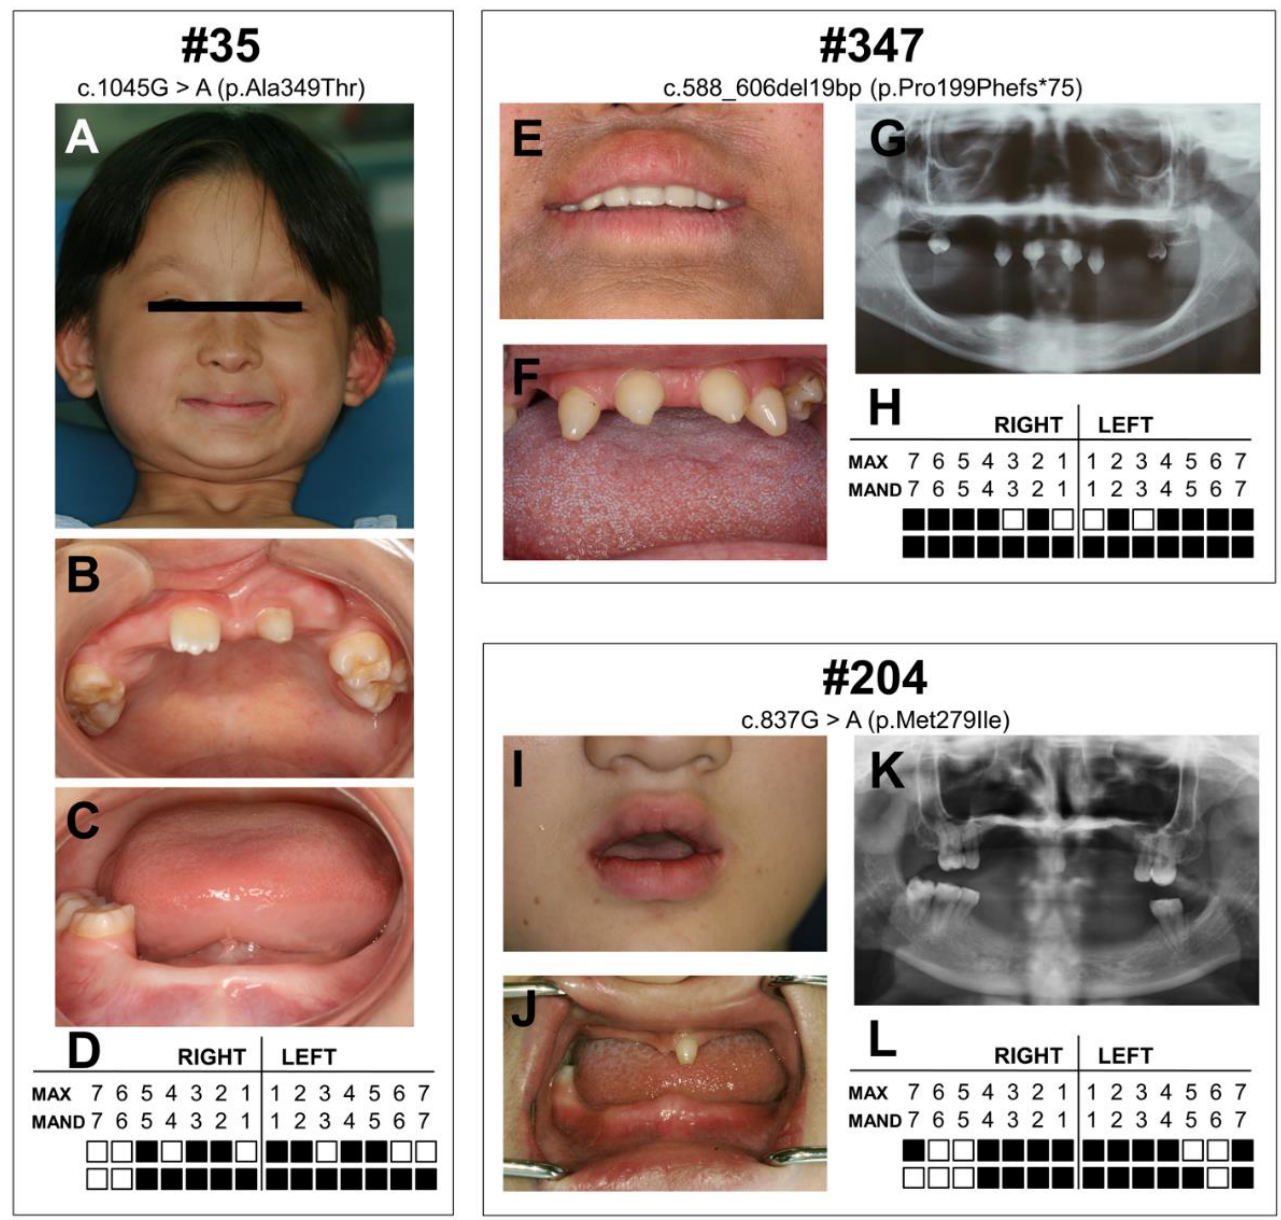
Figure 1. Clinical features of patients with X-linked hypohidrotic ectodermal dysplasia (XLHED). ( A ) Facial photographs of patient #35. ( B , C ) Intraoral photographs of patient #35. ( D ) Schematic of congenitally missing permanent teeth of patient #35. According to medical records, right maxillary first premolar, right maxillary second molar, left maxillary canine, and right mandibular second molar were in the jawbone and could be found by panoramic radiograph. ( E ) Perioral photographs of patient #347. The patient wore removable dentures. ( F ) Intraoral photographs of patient #347. ( G , H ) Panoramic radiograph and schematic of congenitally missing permanent teeth of patient #347. ( I ) Perioral photographs of patient #204. ( J ) Intraoral photographs of patient #204. ( K , L ) Panoramic radiograph and schematic of congenitally missing permanent teeth of patient #204. Solid squares indicate congenitally missing teeth. Max: indicates maxillary. Mand: